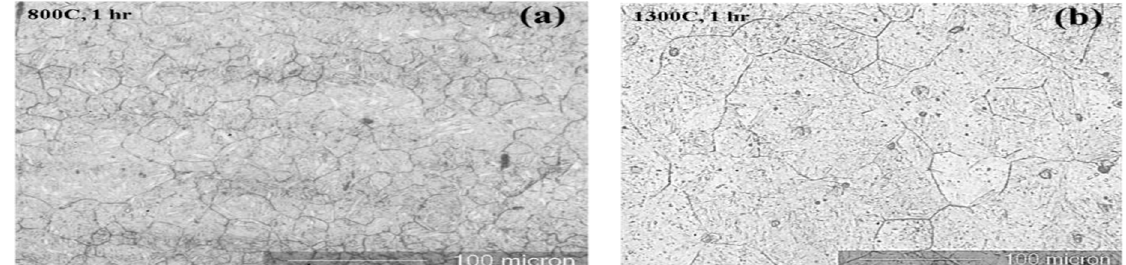
Fig. 5: Optical Micrographs of Sample-B at (a) 800°C and (b) 1350 o C